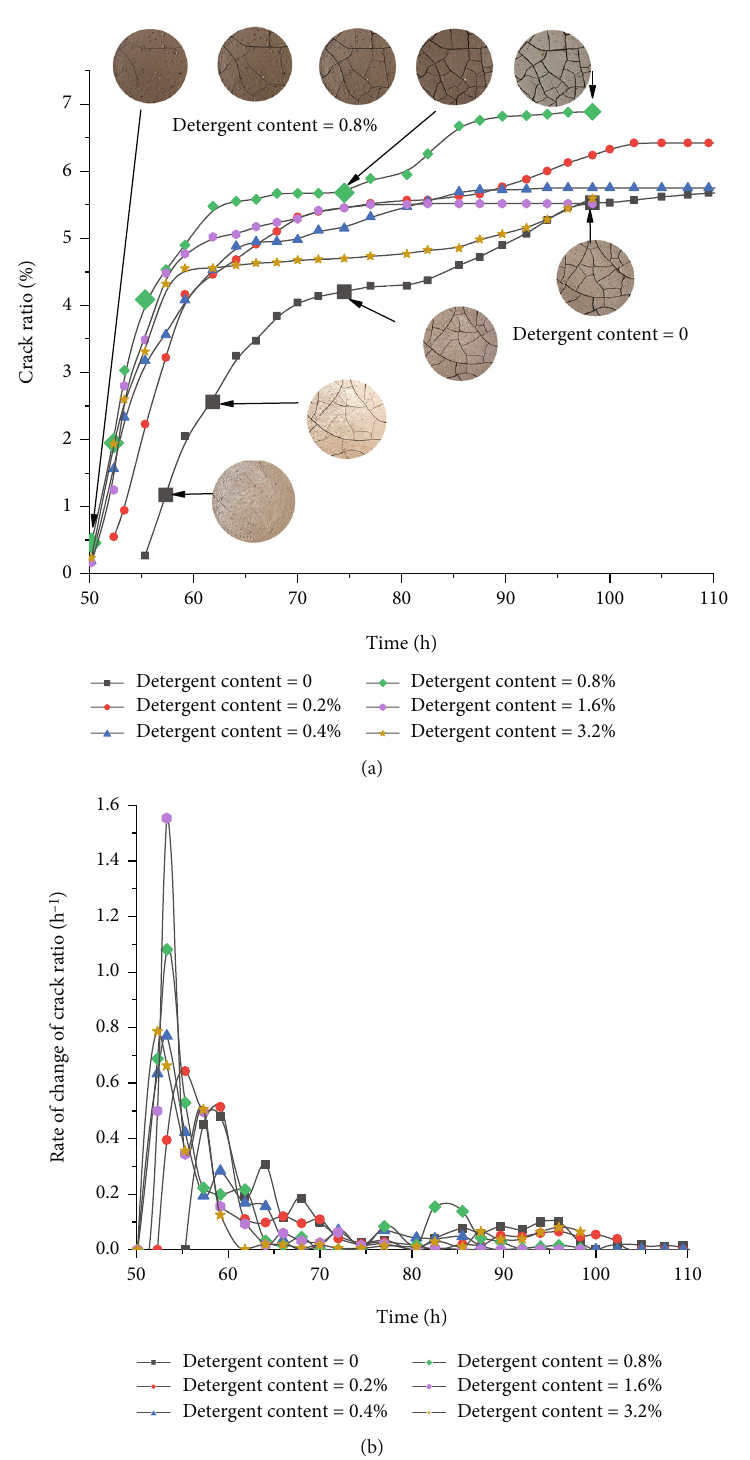
Figure 8: Changes in crack ratio and rate of change of crack ratio with time. (a) Images of the sample, from left to right, with 0.8% detergent at 50h, 52h, 55h, 74h, and 98h. (b) Images of the control sample at 57h, 62h, 74h, and 98